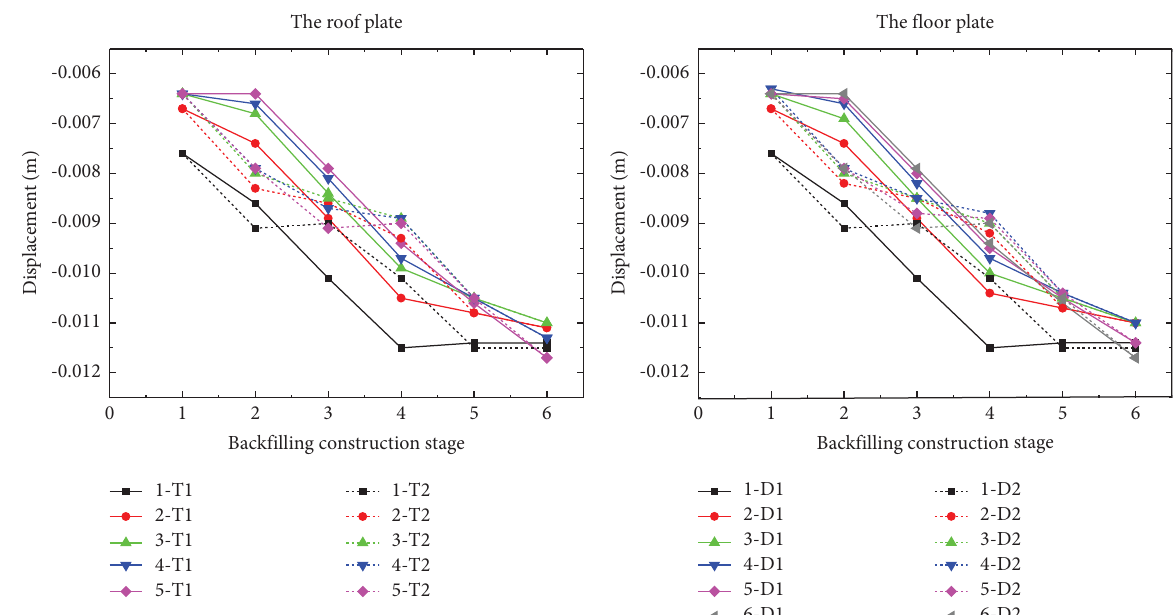
Figure 17: ( Y )-direction virtual displacement of the roof/foor in the left-to-right backflling